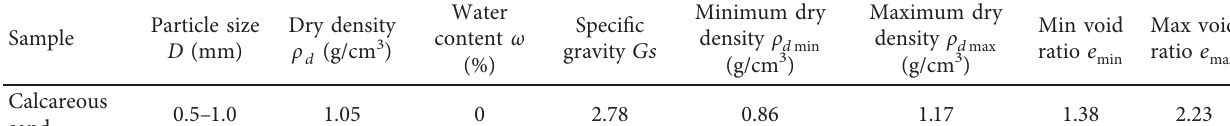
Table 1: Physical parameters of the calcareous sand tested.